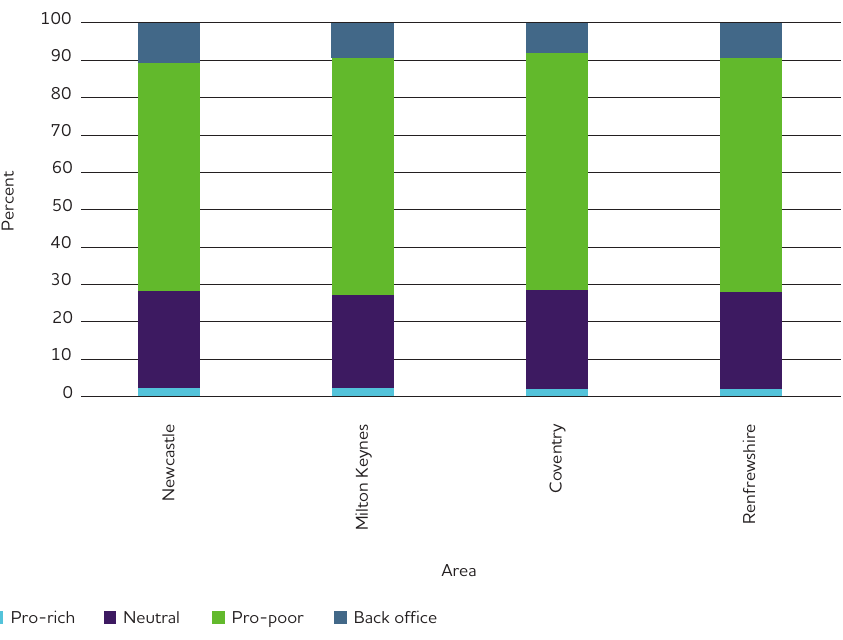
Figure 21: Proportion of total spend by distributional character of service